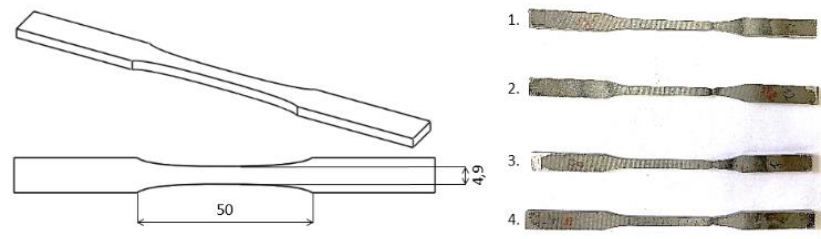
Figure 3. Tensile-test-specimen description.